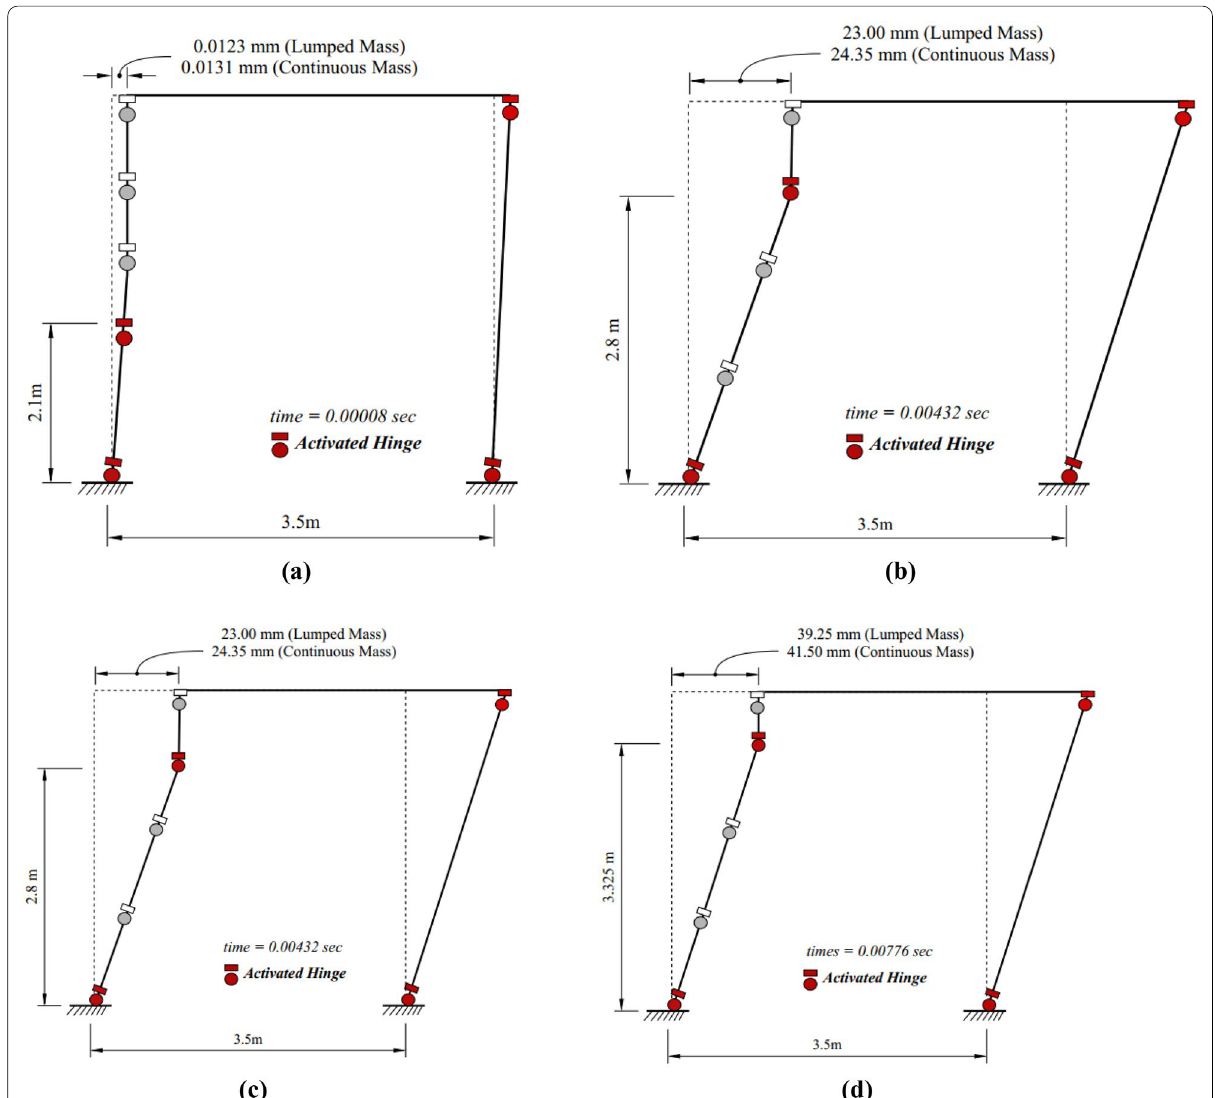
It is found that for pressure pulses 3 P c < P 0 < 6 P c the two traveling plastic hinges coalesce before the pulse ter- minates; whereas, if pressure pulse P 0 > 6 P c , then the traveling hinges coalesce after the pulse terminates at t = τ . In the former case, Eqs. (50), (53), and (54) can be used; whereas, in the latter case, again (50), (53), and (54) can be used to get the transverse acceleration, velocity 0 < t ≤ τ and displacement between . For the subsequent interval τ ≤ t ≤ T 1 , when the pressure pulse is removed, 2 W 2 = 0 the acceleration d . Thus, 2 / dt